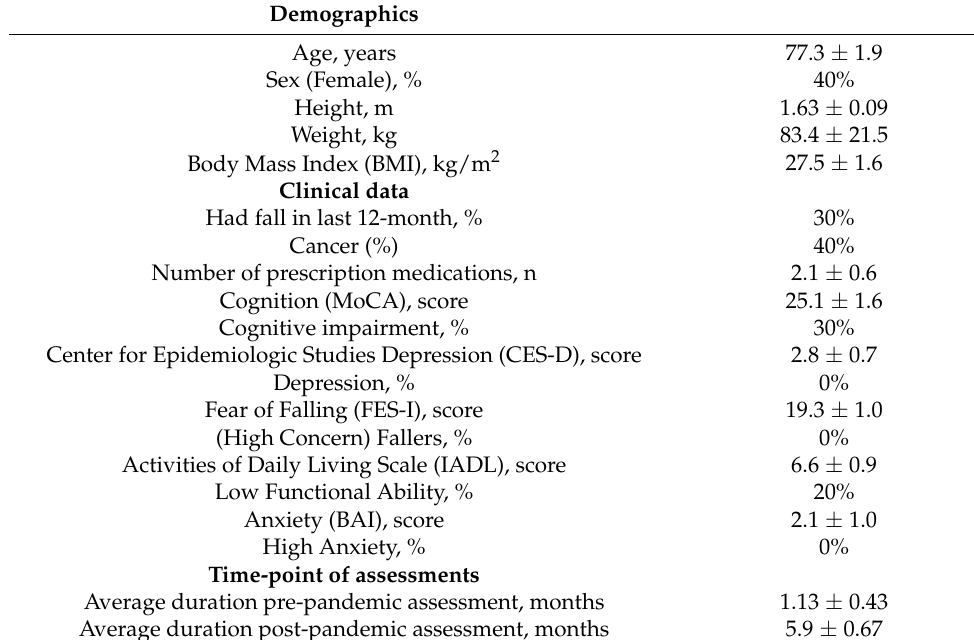
Table 1. Demographic and clinical information of the participants. Values are presented as mean ± standard error (SE), or percentage (%).